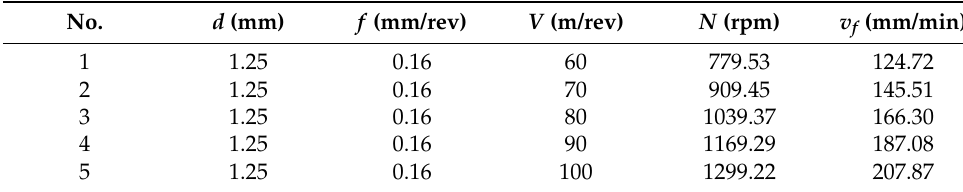
Table 3. Machining parameters used for the cutting speed variation tests.